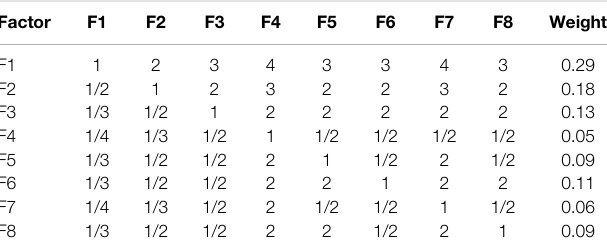
TABLE 4 | Pairwise comparison matrix ofthefactors used inthe AHP and the fi nal weights of the factors. See Table 3 for the factors.